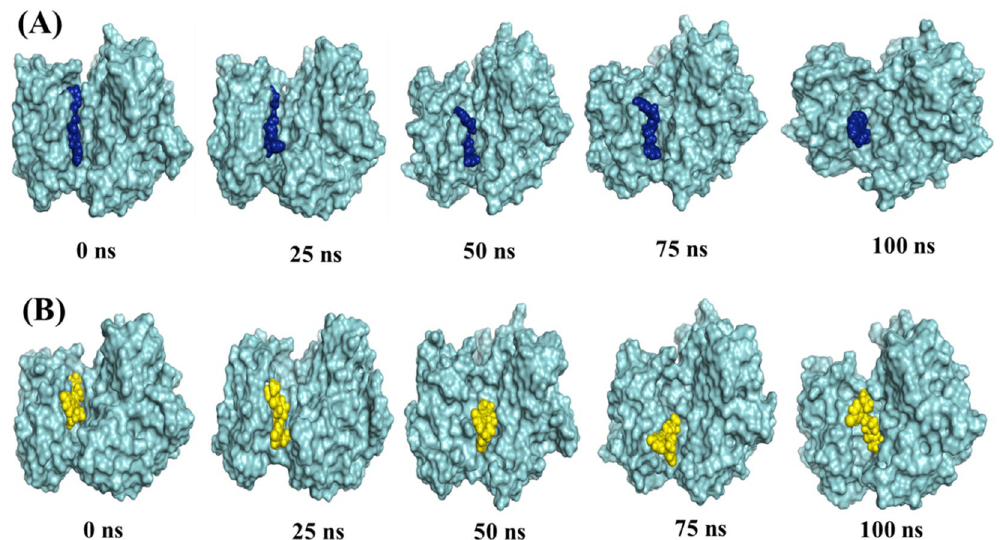
Figure 7. Binding poses of 15K and inhibitor 2 over the course of 100 ns MD simulation. The crystal structure of PAK1 is shown as cyan surface with 15K (Blue) and inhibitor 2 (Yellow) as spheres in ( A ) and ( B ),